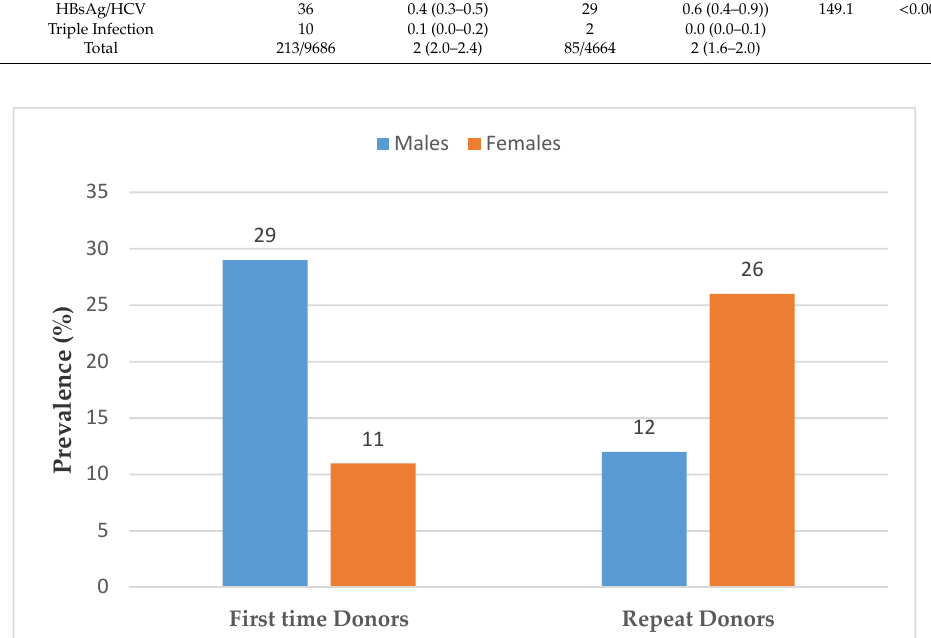
Figure 4. Annual prevalence rates of HBV in blood donors from 2003–2018 by age group.